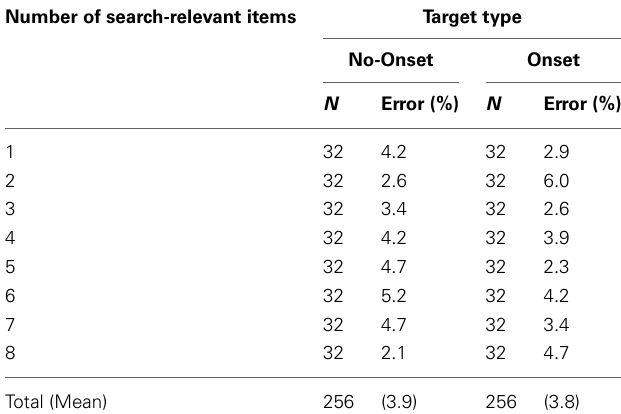
Table 5 | Number of trials ( N ) and mean percentage errors (%) for different target type and number of search-relevant items in Experiment 3.